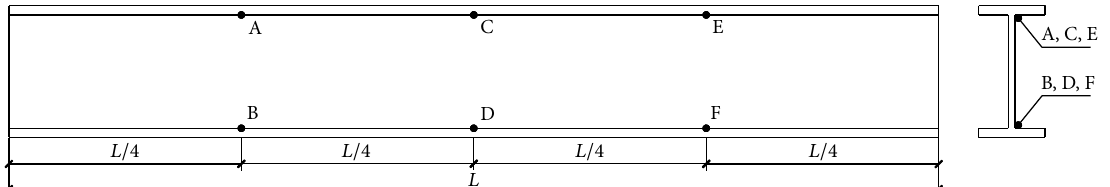
Figure 22: Impact process.